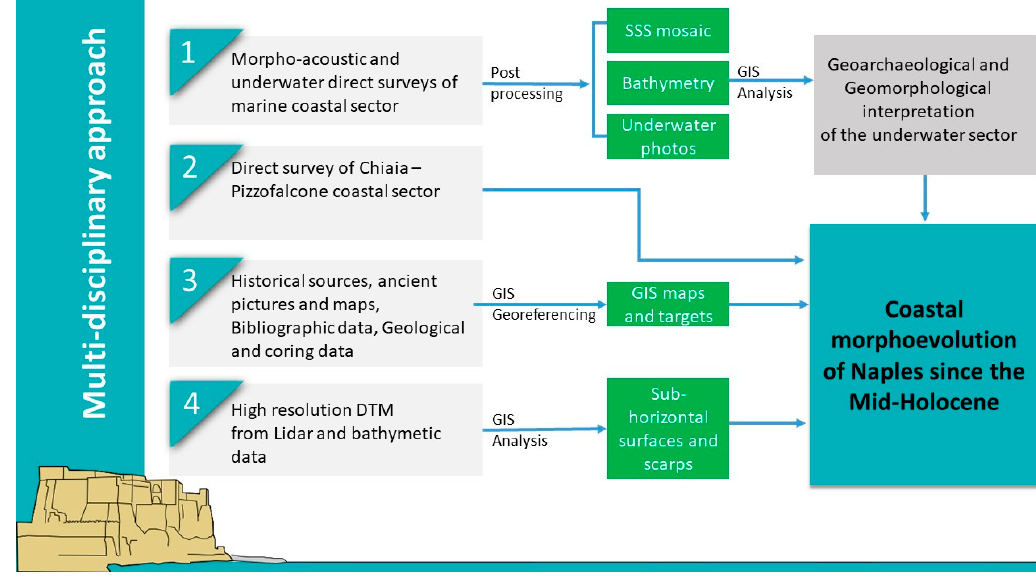
Figure 2. Flowchart describing the methodological approach used in this research.